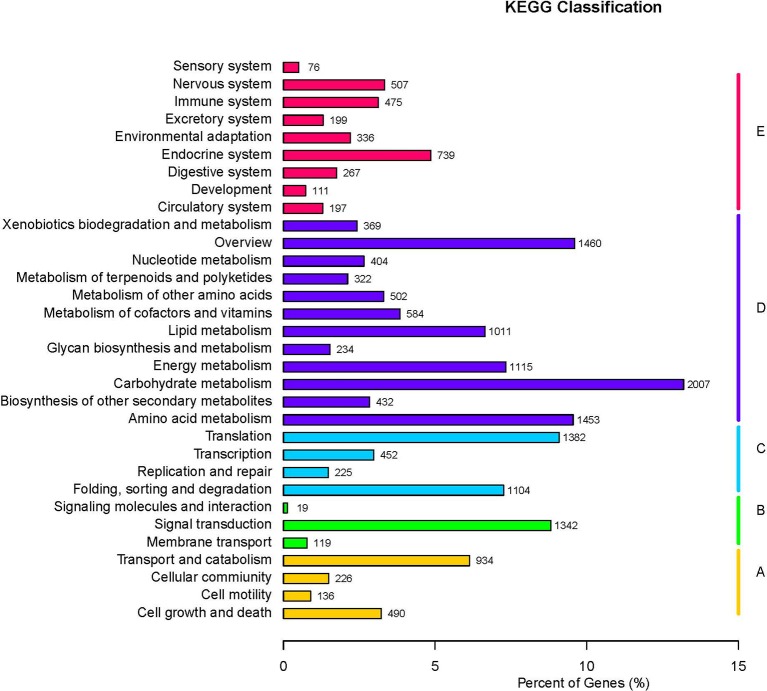
Kyoto encyclopedia of genes and genomes (KEGG) classification of unigenes.